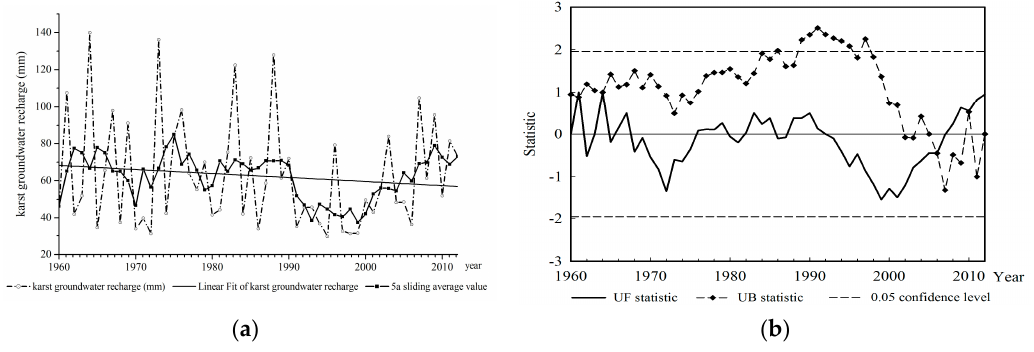
Figure 6. Annual karst groundwater recharge amount variation trend and mutation analysis in the Fenhe Reservoir-Zhaishang zone of the Jinci Spring region: ( a ) annual karst groundwater recharge amount variation trend; ( b ) annual karst groundwater recharge amount variation trend mutation analysis.